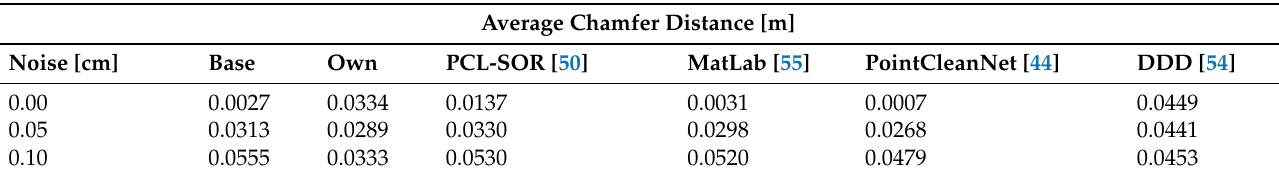
Table 4. Summary of the comparison with other methods on different noise levels.